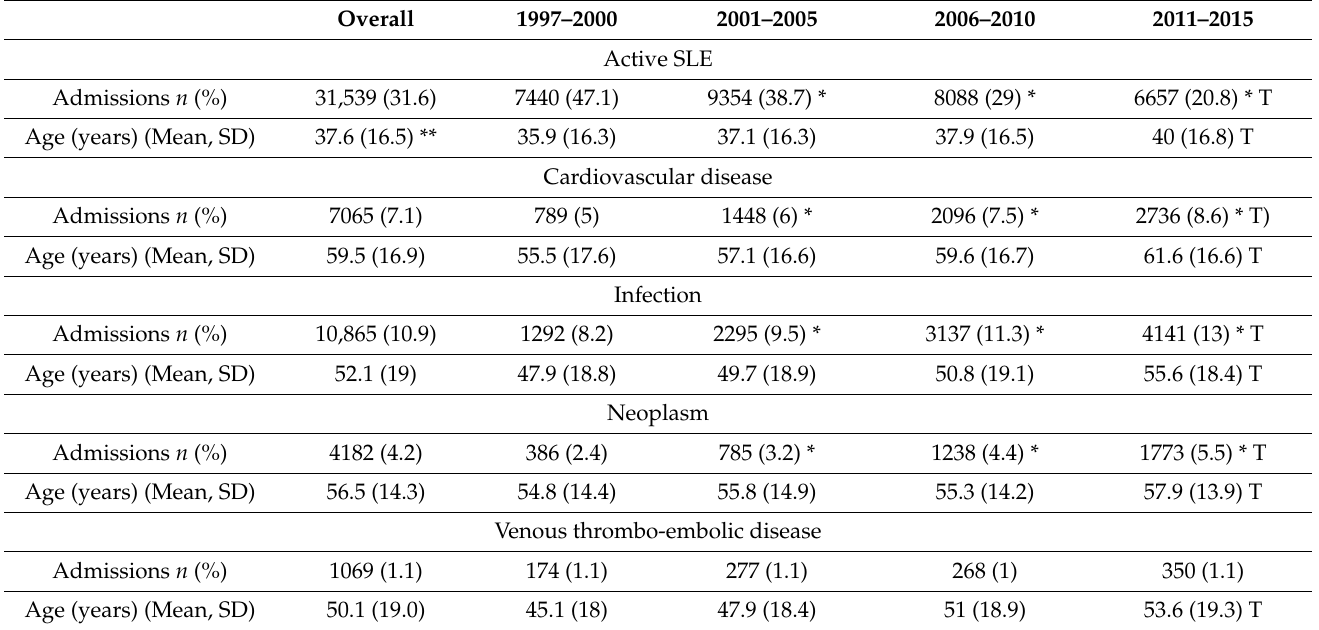
Table 2. Rate of SLE hospitalized individuals by study period and clinical